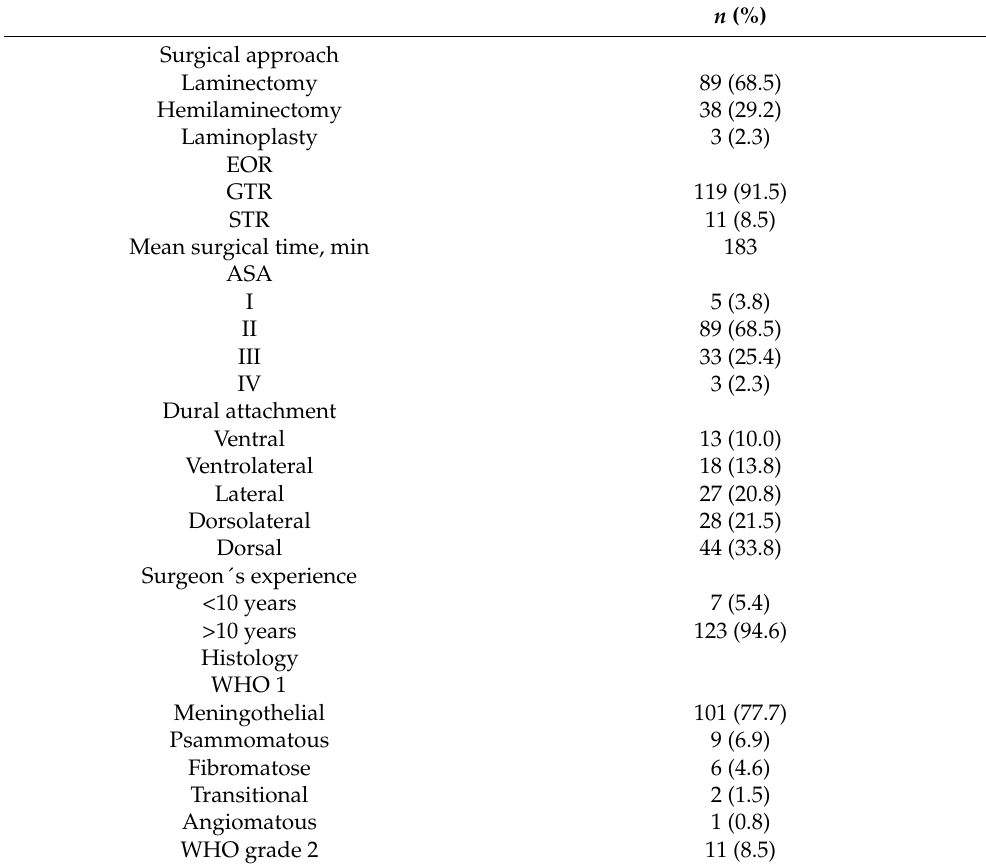
Table 2. Surgical data.